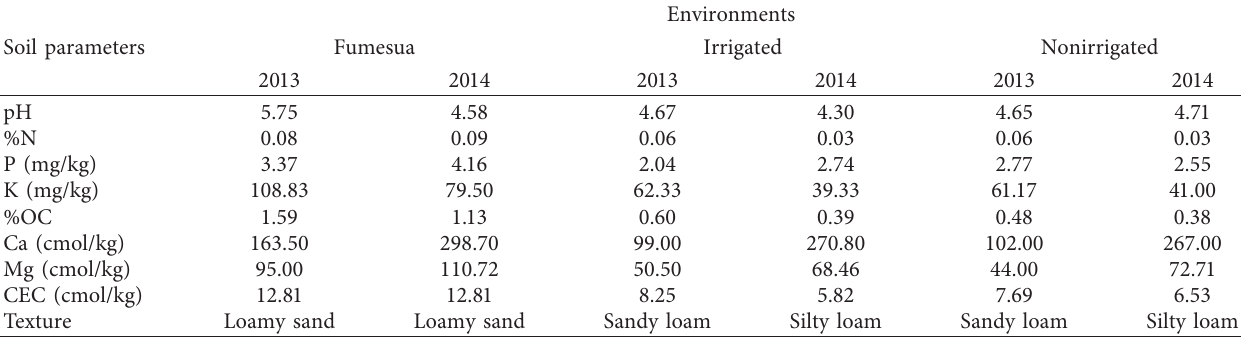
Table 3: Soil physical and chemical characteristics at the study sites in 2013 and